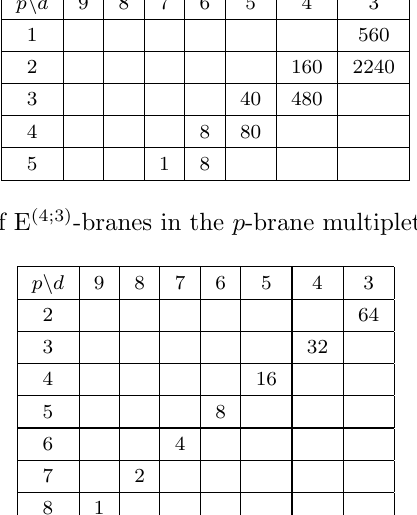
Table 27 . Number of E (4;6) -branes in the p -brane multiplet in d -dimensions [17]. p \ d